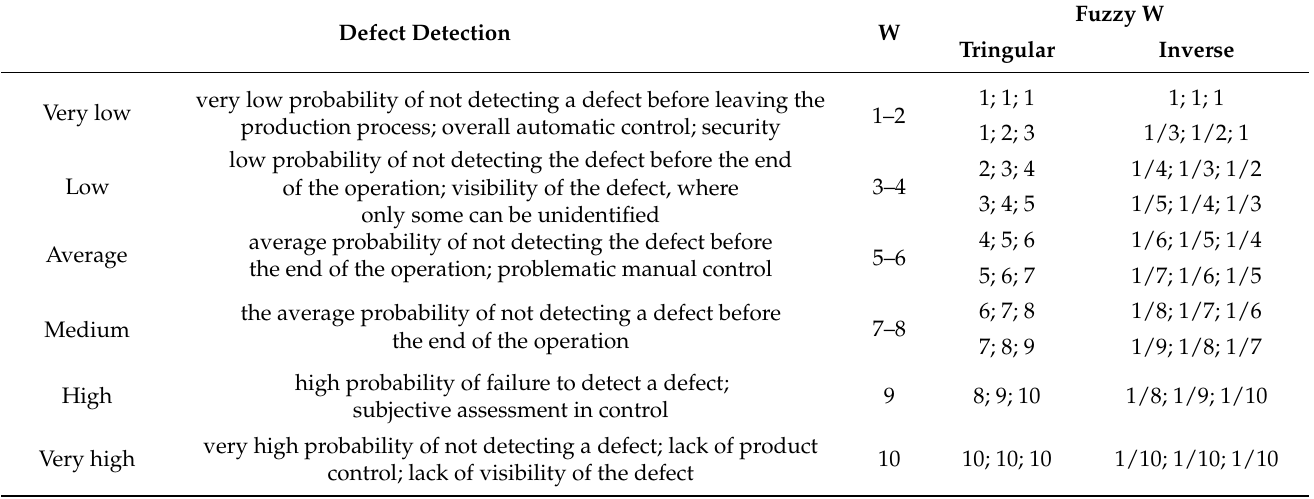
Table 2. Characteristic of assumed priority number W—possibility to detect defects. Own study based on [27,31,42].